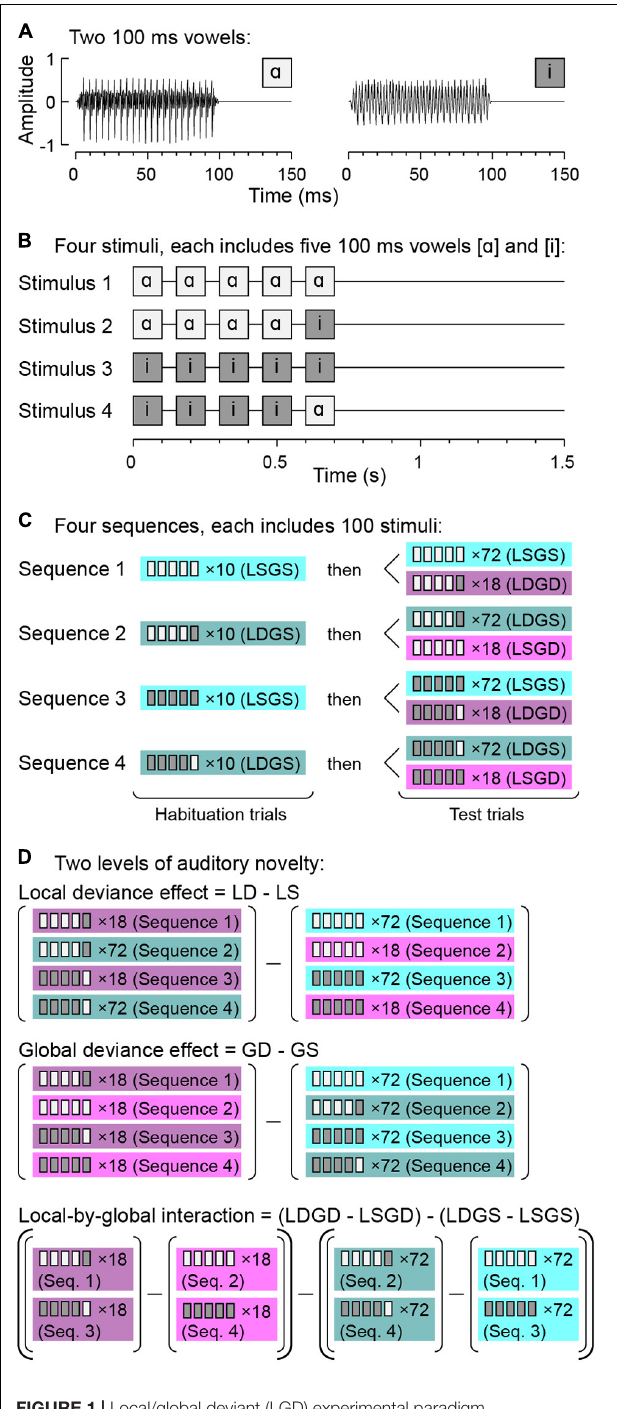
FIGURE 1 | Local/global deviant (LGD) experimental paradigm. (A) Waveforms of the two vowels/ A /and/i/used to construct the experimental stimuli. (B) Schematic of the four experimental stimuli. (C) Stimulus sequences. (D) Comparisons between responses to specific stimulus types to characterize LD and GD effects and L × G interactions. Note that in subject R413, a slightly modified paradigm was used, where each sequence included 110 stimuli. The 10-trial habituation sequence was followed by 80 GS and 20 GD test trials in this subject. GD, global deviant; GS, global standard; LD, local deviant; LS, local standard. Modified from Nourski et al.